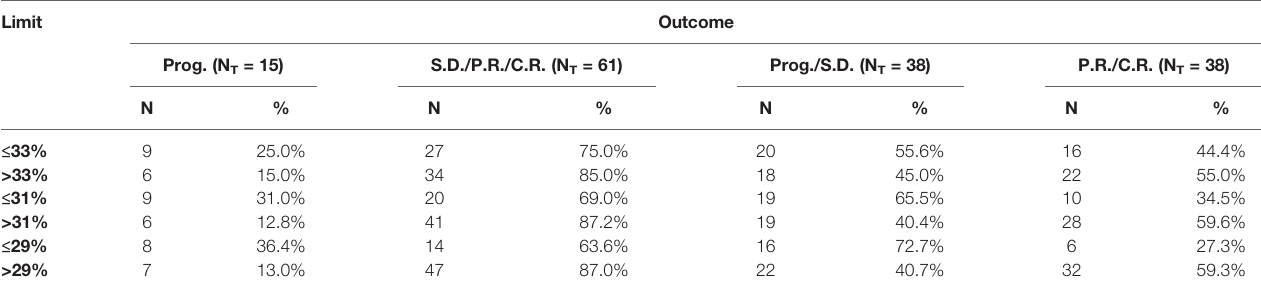
TABLE 5 | Sensitivity and speci fi city values for three different cutoff points of percentage difference of MNf.